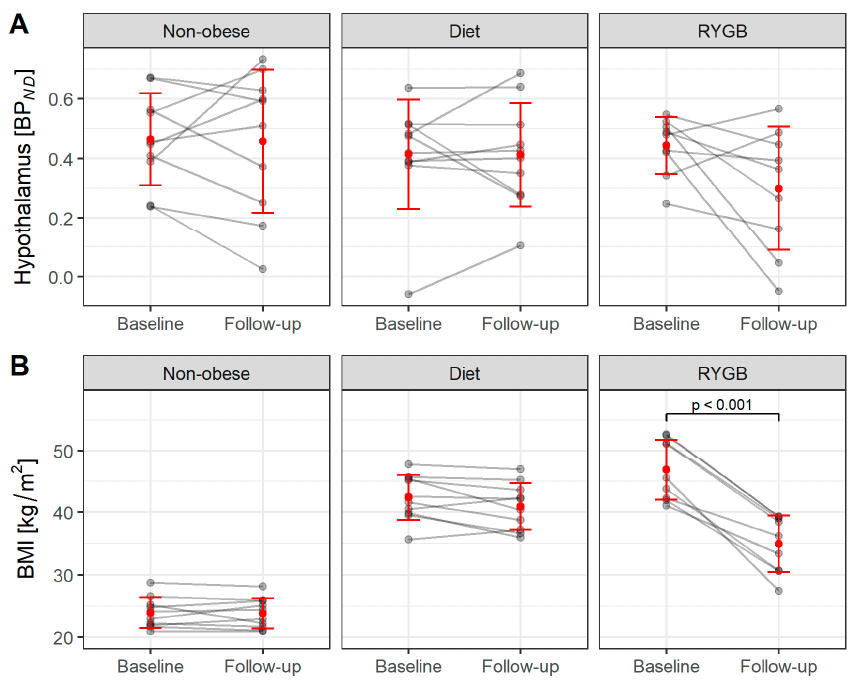
Figure 4. NAT BP ND in the hypothalamus ( A ), and BMI values ( B ) of study participants before and after 6 months of intervention. The red dots represent the mean value, and error bars indicate the standard